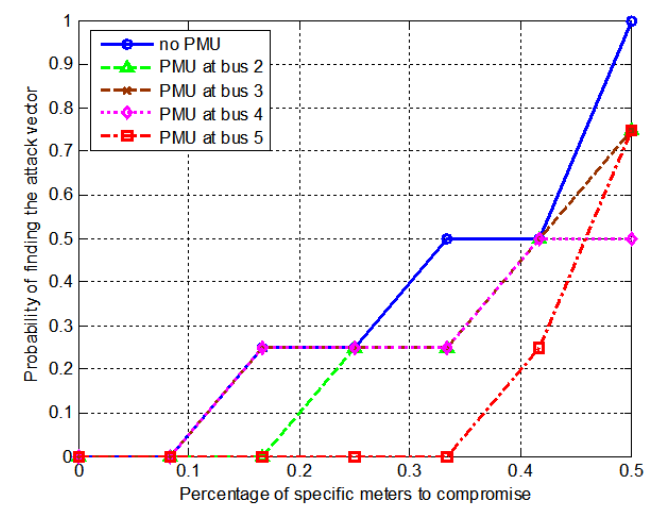
Figure 2. Probability of finding the attack vector in example 5-bus system with or without phasor- measurement unit (PMU).